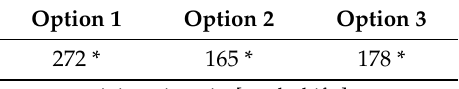
Table 2. Statement of duration of the works envisaged for the implementation of the scope of work provided for in options 1, 2, 3.